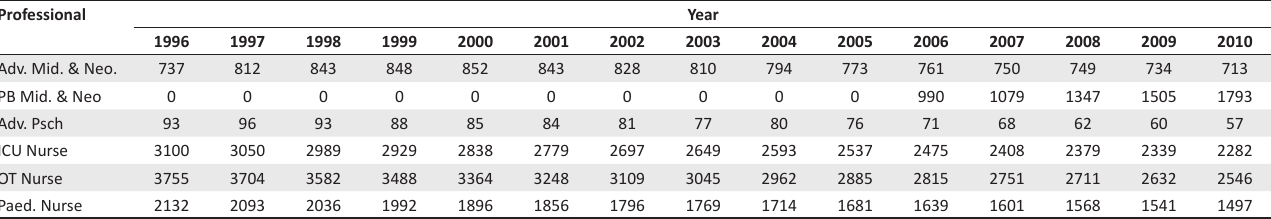
FIGURE 1: Nursing specialist qualifications, 1996–2010. TABLE 1: Nursing specialist qualifications,